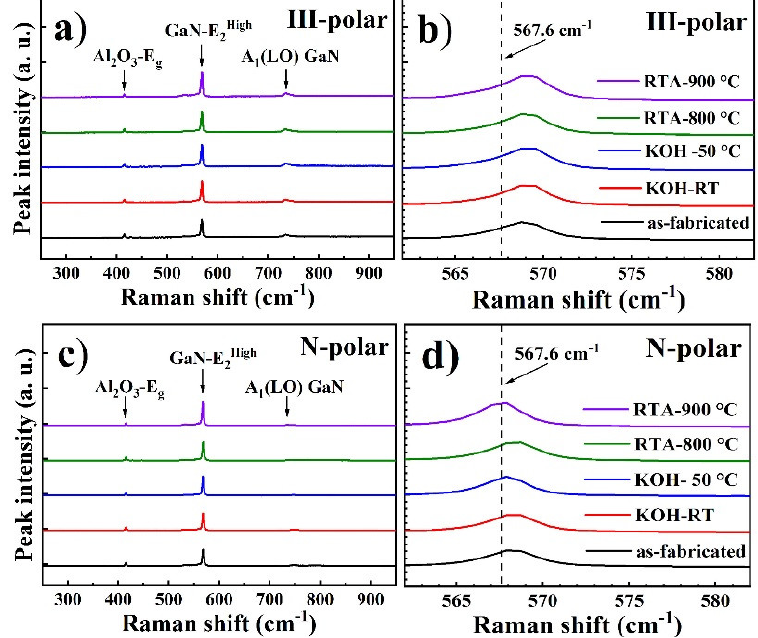
Figure 8. Full-range ( a , c ) and zoom-in ( b , d ) Raman spectra of III-polar ( a , b ) and N-polar ( c , d ) nanopillar MQWs before and after chemical and thermal treatments.